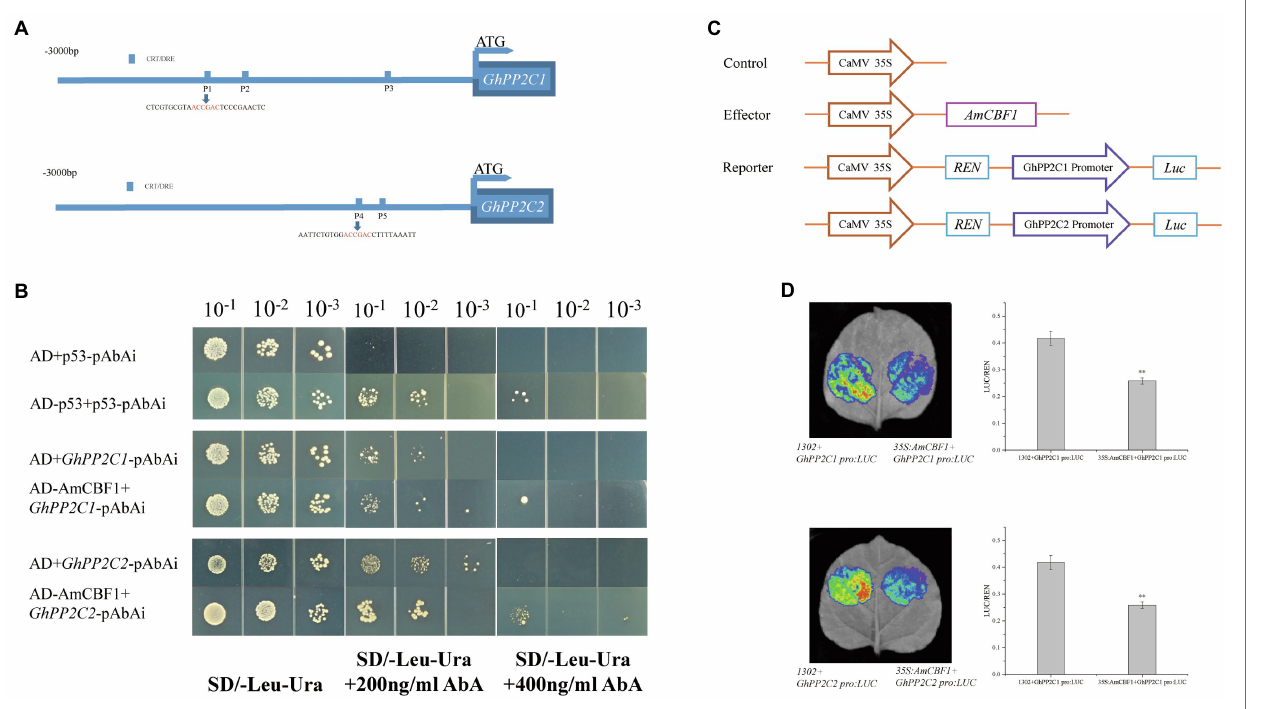
FIGURE 5 | AmCBF1 transcription factor inhibition of the expression of GhPP2C1 and GhPP2C2 . (A) Schematic diagram of the CRT/DRE binding element in the 3,000 bp promoter upstream of the ATG start codon of GhPP2C1 and GhPP2C2. (B) Yeast one-hybrid analysis showing binding of AmCBF1 to the promoter sequence of GhPP2C1 or GhPP2C2 . Yeast cells were cultured at serial dilutions of 1:10, 1:100, and 1:1,000 on SD/ − Leu/ − Ura medium supplemented with or lacking 400 ng ml − 1 aureobasidin A. The pGADT7 vector was used as a negative control. (C) Schematic diagram of vector construction of the reporter and effector plasmids for transient transcriptional activity assays in tobacco. REN, Renilla luciferase; LUC, firefly luciferase. (D) Tobacco leaf live-imaging observations. Red indicates the strongest fluorescence signal intensity. Luciferase activity was normalized to the respective REN activity and expressed as relative expression. Error bars indicate the standard error ( n = 3 biological replicates). ** p < 0.01 (Student’s t